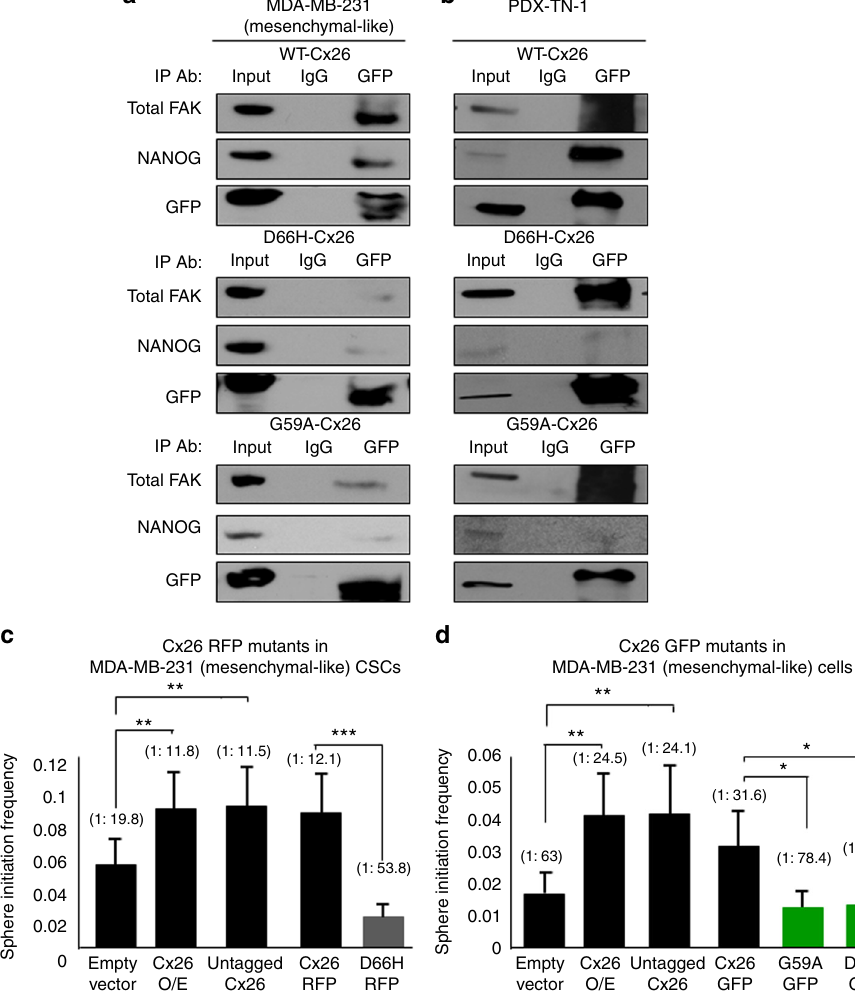
Fig. 6 Cx26 mutants failing to complex with NANOG or FAK/NANOG disrupt the self-renewal capacity of TNBC CSCs. a , b After transfection of plasmids expressing GFP-fused Cx26 wild-type and mutant proteins, immunoprecipitation was performed using a GFP antibody in MDA-MB-231 and PDX TN-1 cells, and the resulting immunoprecipitates were probed with FAK, NANOG, and GFP antibodies. c Stem cell frequencies determined by limiting dilution sphere- forming assays indicate that the expression of the D66H-RFP mutant Cx26 in MDA-MB-231 CSCs signi fi cantly reduced the stem cell frequency compared with the expression of the wild-type Cx26-RFP and empty vector control. d D66H-GFP or G59A-GFP mutant Cx26 expression in MDA-MB-231 parental cells failed to increase stem cell frequency compared with the expression of the wild-type Cx26-GFP (* p < 0.05, ** p < 0.01, *** p < 0.001). All the error bars indicate the range between the upper and median